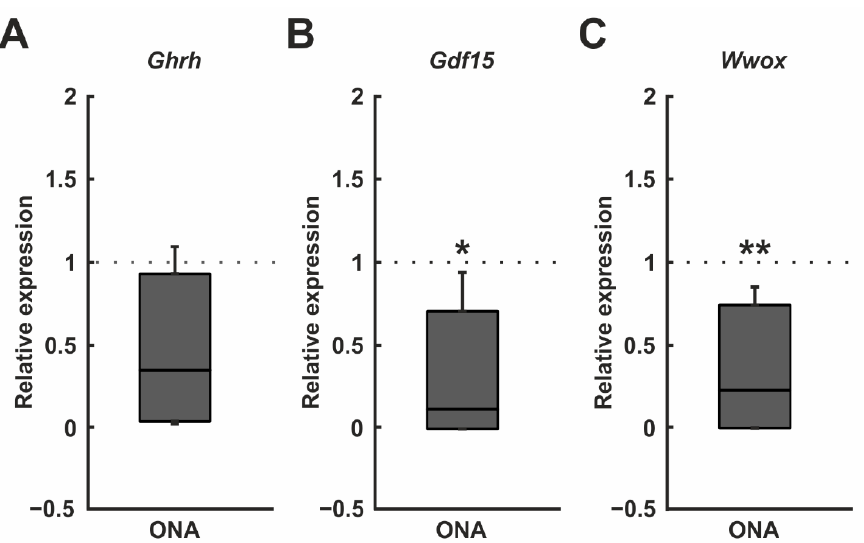
Figure 9. Downregulation of Gdf15 and Wwox . ( A ) RT-qPCR analyses of Ghrh mRNA levels revealed no significant differences between both groups. ( B ) The mRNA expression levels of Gdf15 were downregulated in the ONA samples ( p = 0.016). ( C ) A downregulation of the Wwox mRNA expression was detected in the ONA group ( p = 0.002). Values are median ± quartile ± minimum/maximum. The dotted lines represent the relative expression of the control group. * p < 0.05, ** p < 0.01.